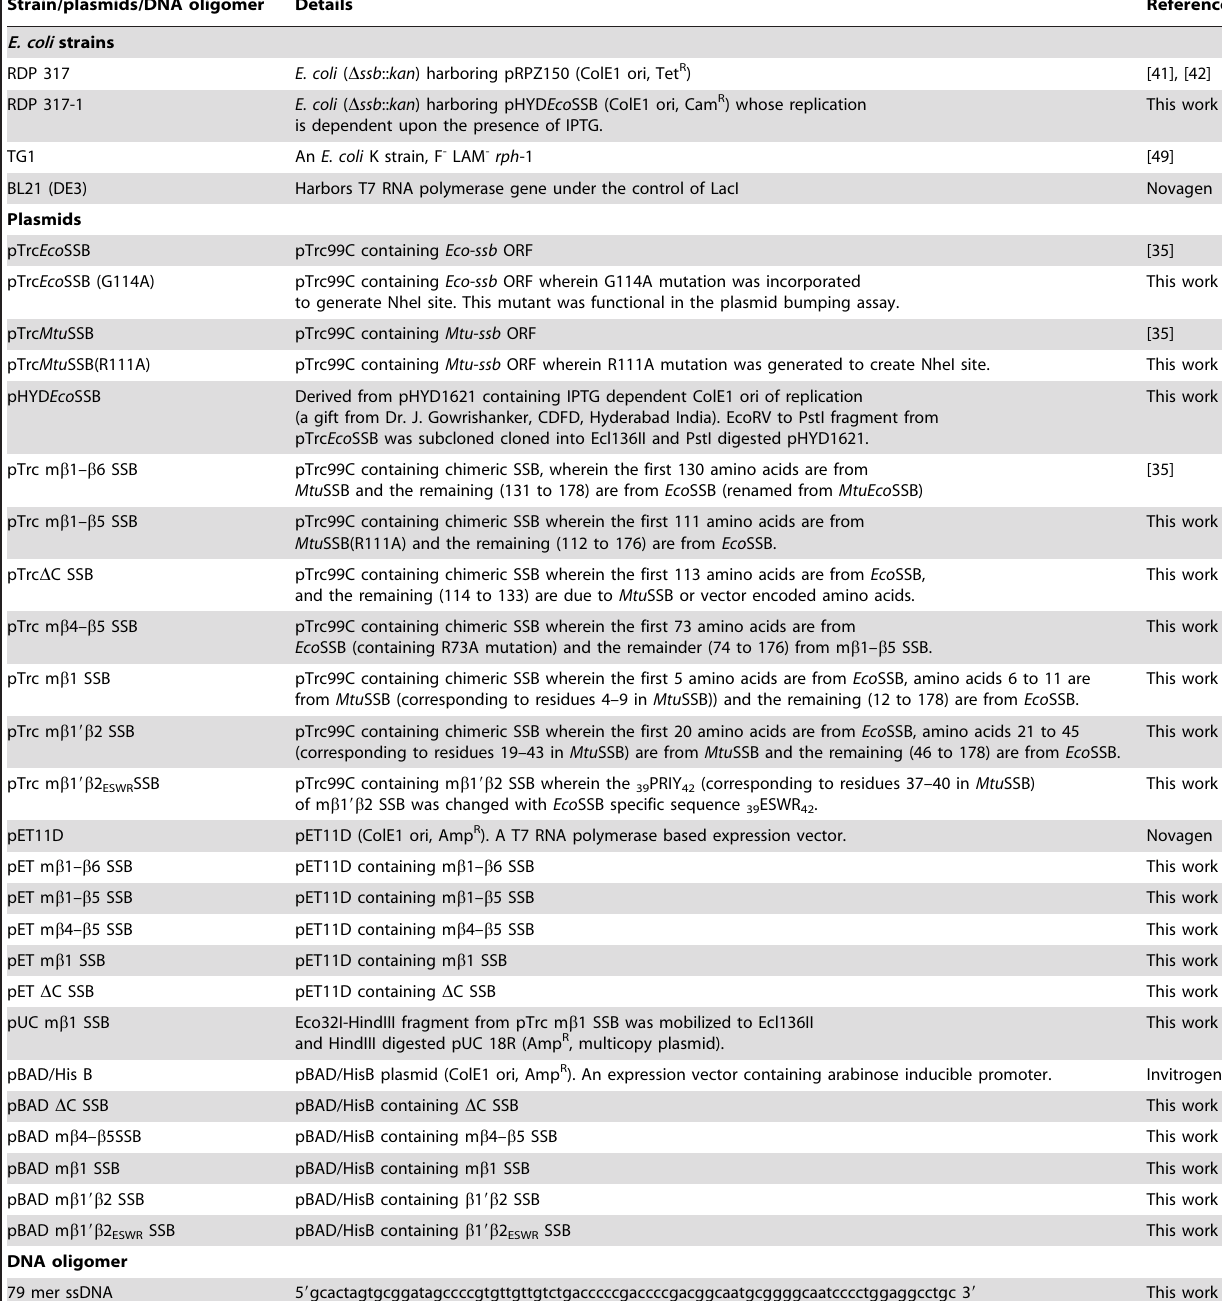
Table 1. List of strains, plasmids and DNA